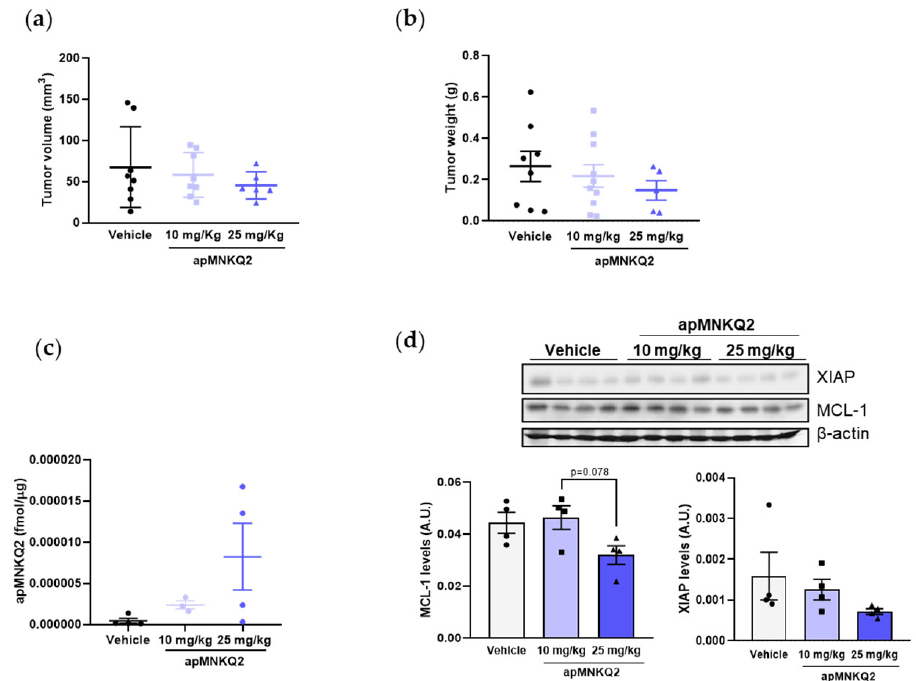
Figure 6. apMNKQ2 efficacy in an adenocarcinoma xenograft model. ( a , b ) Reduction in ( a ) volume and ( b ) weight of A549 xenografts following treatment with apMNKQ2 at 10 and 25 mg/kg daily. Mice were treated intraperitoneally with apMNKQ2 or vehicle control (selection buffer) for 4 weeks. Scatter plots represent the mean ± SEM from 6-8 tumors. Solid black circles (vehicle), blue squares (apMNKQ2 at 10 mg/Kg) or blue triangles (apMNKQ2 at 25 mg/Kg) represent one individual value. ( c ) Quantification of apMNKQ2 levels in tumors by qRT-PCR. RNA fraction, where apMNKQ2 is found, was obtained from tumor samples and used in qPCR analyses as described in Material and Methods. Results are expressed as pmol/ µ g of tissue. Scatter plot represents the mean ± SEM from 3–4 tumors. Each solid circle represents one individual value. ( d ) Proteins were obtained from tumor samples as described in Material and Methods and lysates (20 µ g) were subjected to SDS-PAGE (12%). Western blotting was performed using specific antibodies (see Supplementary Table S1). Actin detection was used as a loading control. Blots are shown on the top of the graphs. The bars represent mean protein levels ± SEM, expressed as arbitrary units (A.U.) for 4 tumors from each treatment arm. Each solid black symbol represents one individual